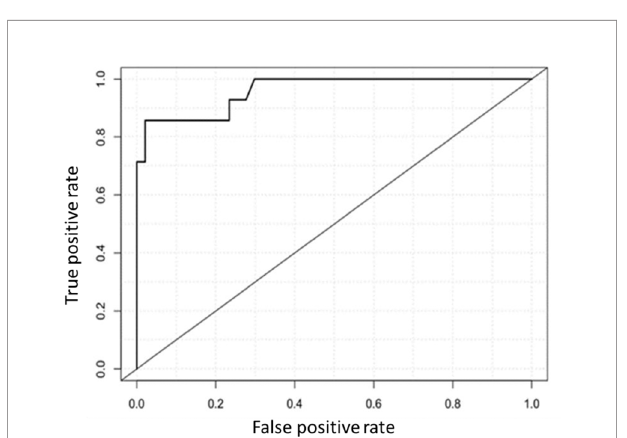
FIGURE 4 | Receiver-operating characteristic (ROC) curve for prediction of sentinel lymph node status through a logistic model based on AXL expression and Breslow score as signi fi cant covariates. The area under the curve is